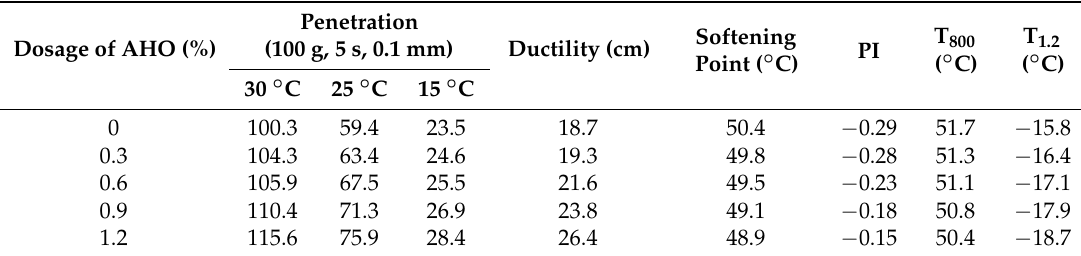
Table 6. AHO’s effect on the performance of